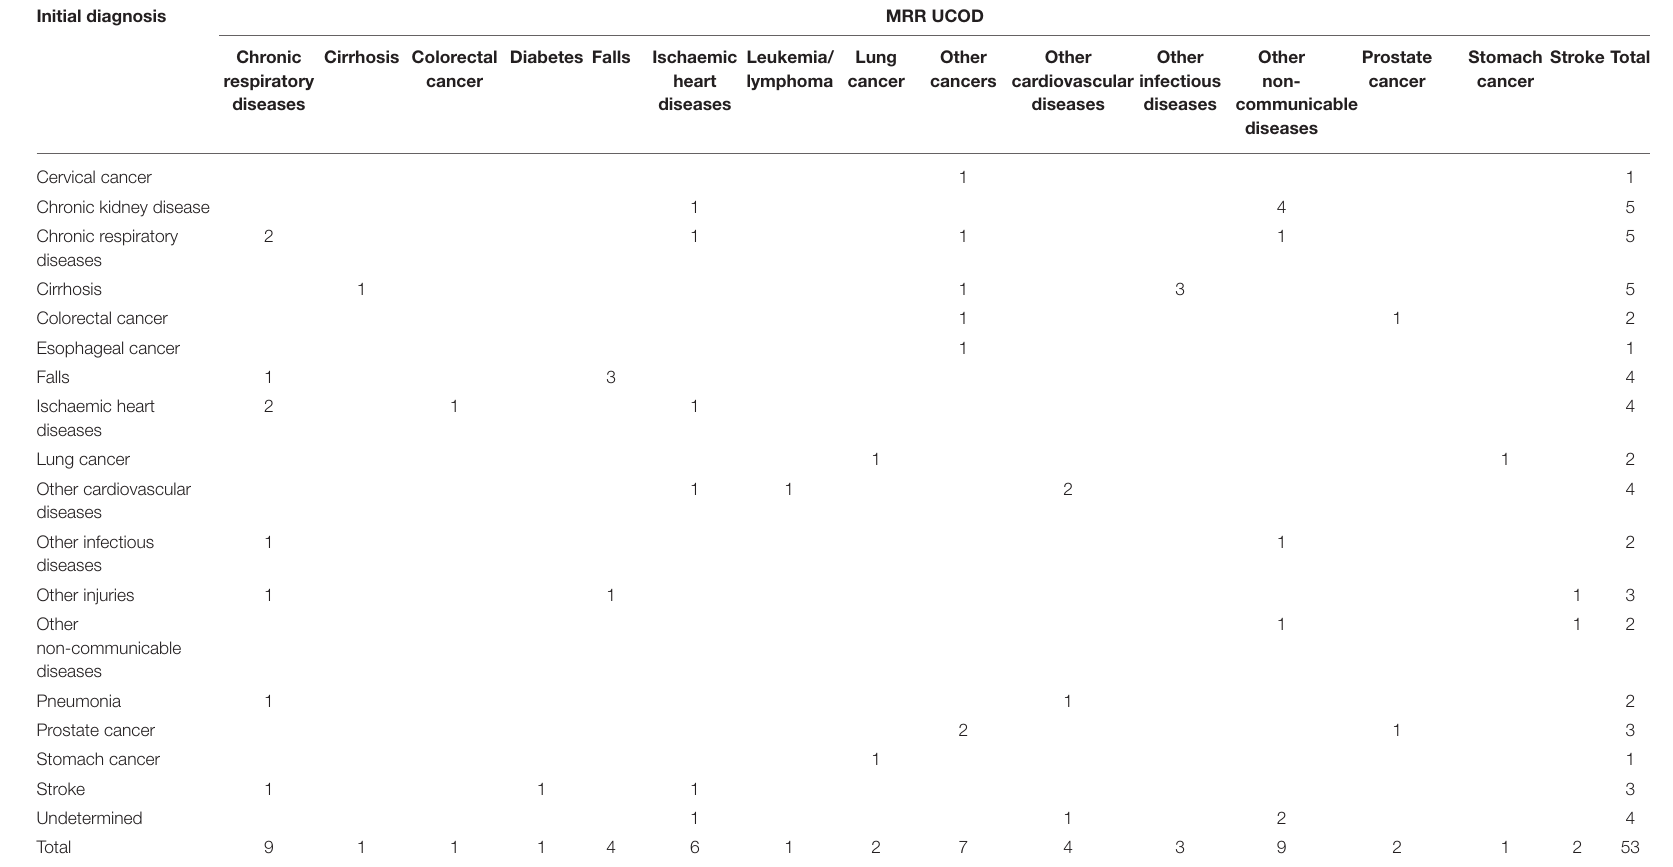
TABLE 6 | The concordance between initial diagnosis and MRR results of the 53 changed cases where SmartVA led to a change in diagnosis. Initial